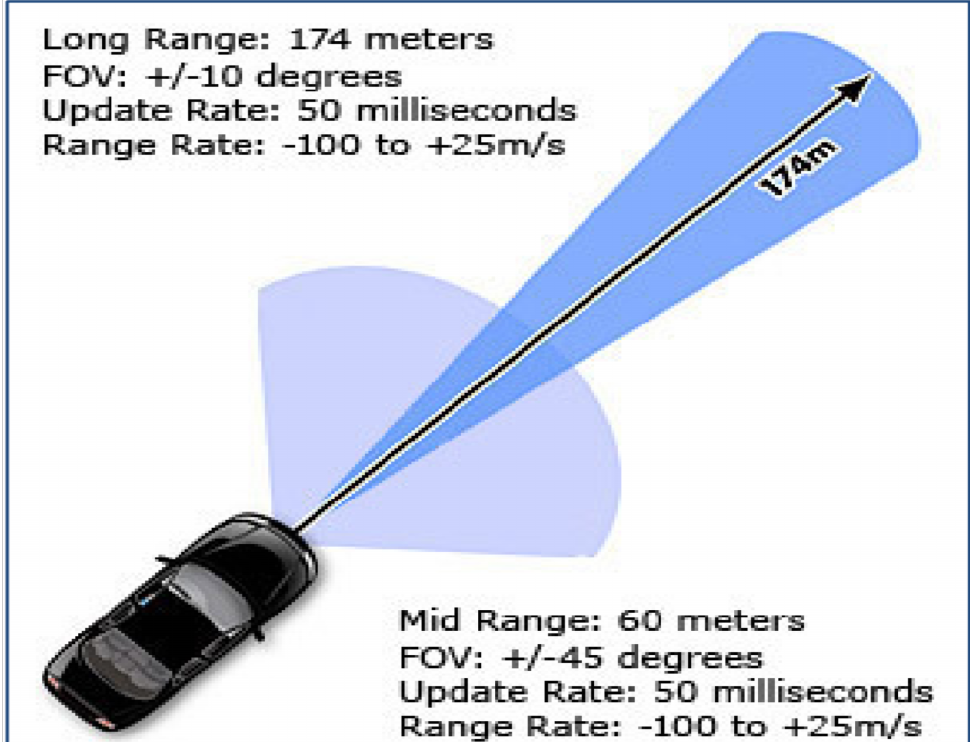
Figure 6. Multiple fields of vision zones for the Aptiv radar for increased safety measures [53].